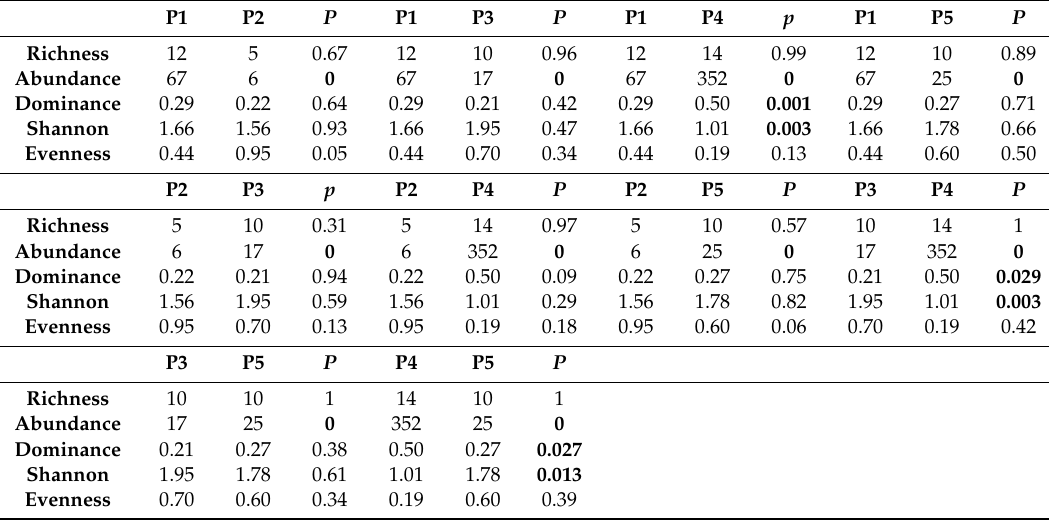
Table 6. Richness (species number), abundance (specimens’ number), dominance (Simpson’s index), diversity (Shannon–Wiener H’), evenness indices for saproxylic communities linked to each sampling plot (P) and paired comparisons between them. p = bootstrapping comparisons. Values with statistical significance are highlighted in bold type.